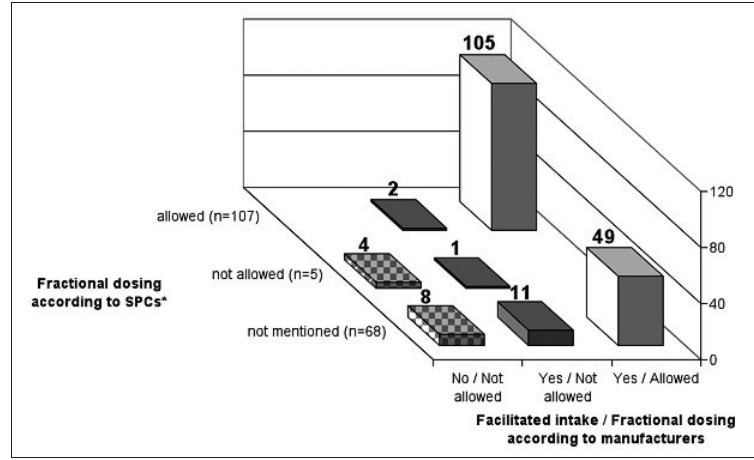
The 180 indexed scored tablets (i.e., «Bruchrille JA» ) in the Hospital Drug Formulary were classified according to the divisibility mentioned in the SPCs*, i.e., if fractional dosing was allowed, not allowed or not mentioned. Missing information was obtained from manufactur- ers and concerned splitting for facilitated intake (Yes or No) or for fractional dosing (Allowed or Not